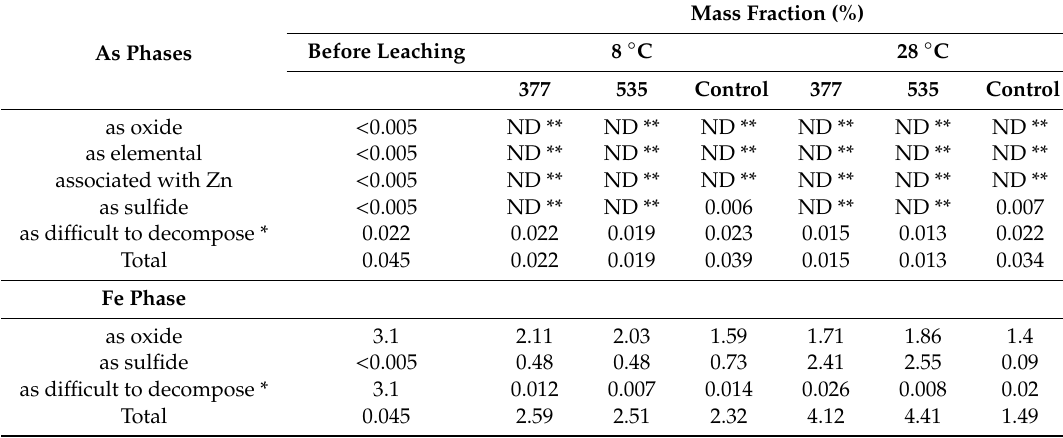
Figure 5. Ferric (Fe 3+ ) concentration ( a ), solution redox potential, and As removal efficiency ( b ) during the bioleaching experiments with different strains at 8 °C. Table 2. The results of the phase chemical analysis of As and Fe in the mine tailings before and after bioleaching.